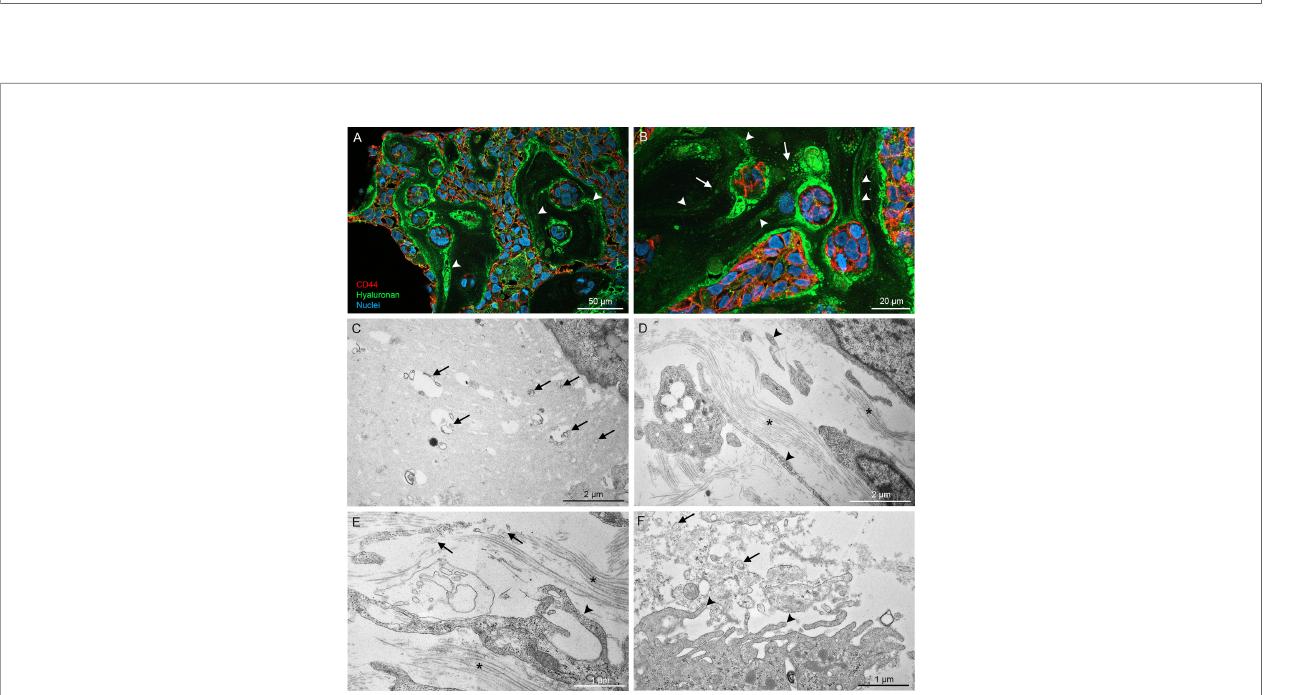
FIGURE 8 | High resolution imaging of CAM tumor sections shows that hyaluronan-rich trails are formed in tumors in ovo. Confocal 3D projections from CAM tumor paraf fi n sections (A, B) derived from MCF10CA cells show high amount of hyaluronan between and around tumor cells and hyaluronan-rich trails (arrowheads in A, B ). TEM images (C – F) show the numerous EVs of variable size and shape in the stromal areas (arrows in C – F ). Asterisks (*) in (D, E) indicate collagen